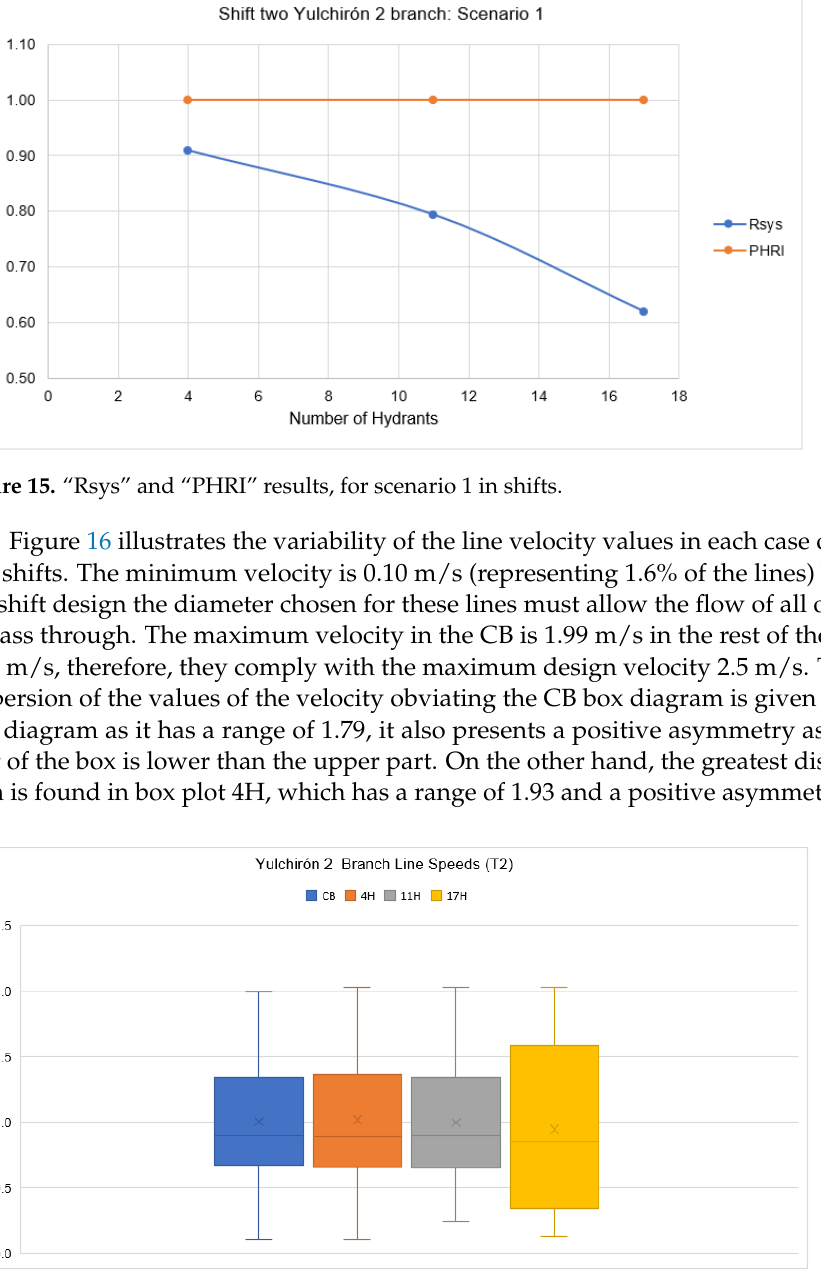
Figure 16. Yulchirón 2 (T2) branch line speeds operating in shifts, scenario 1. Figure 16. Yulchir ó n 2 (T2) branch line speeds operating in shifts, scenario